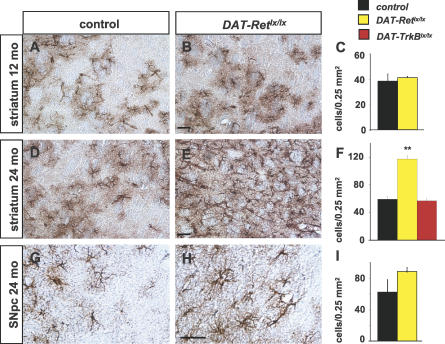
Gliosis in Dorsal Striatum of DAT-Retlx/lx Mice(A, B, D, E, G, and H) Bright-field photomicrographs of dorsal striatum (A, B, D, and E) and SNpc (G and H) of 12-mo-old (A and B) and 24-mo-old (D, E, G, and H) control (A, D, and G) and DAT-Retlx/lx mutants (B, E, and H) stained for GFAP.(C, F, and I) Histograms showing the number of GFAP-positive reactive astrocytes (n = 3–5 per genotype). There is a 2-fold increase in the number of reactive astrocytes in the striatum of 2-y-old DAT-Retlx/lx mutants as compared to wild-type controls and DAT-TrkBlx/lx mutants (F) (p < 0.0001), whereas no difference is seen in 12-mo-old DAT-Retlx/lx mutants compared to controls (C) (p = 0.9). No significant increase in the number of reactive astrocytes is seen in the SNpc of 24-mo-old DAT-Retlx/lx mutants compared to controls (I) (p = 0.24). **, p < 0.01 (Student t-test). Scale bars indicate 50 μm.